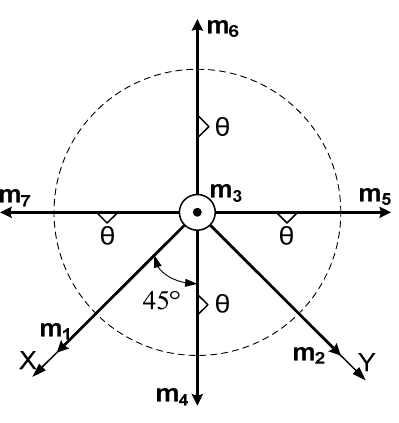
Figure 6. Configuration 4 redrawn.